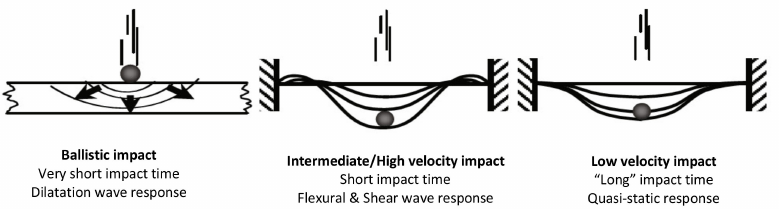
Figure 1. Comparison of high- and low-velocity impact responses (adapted from